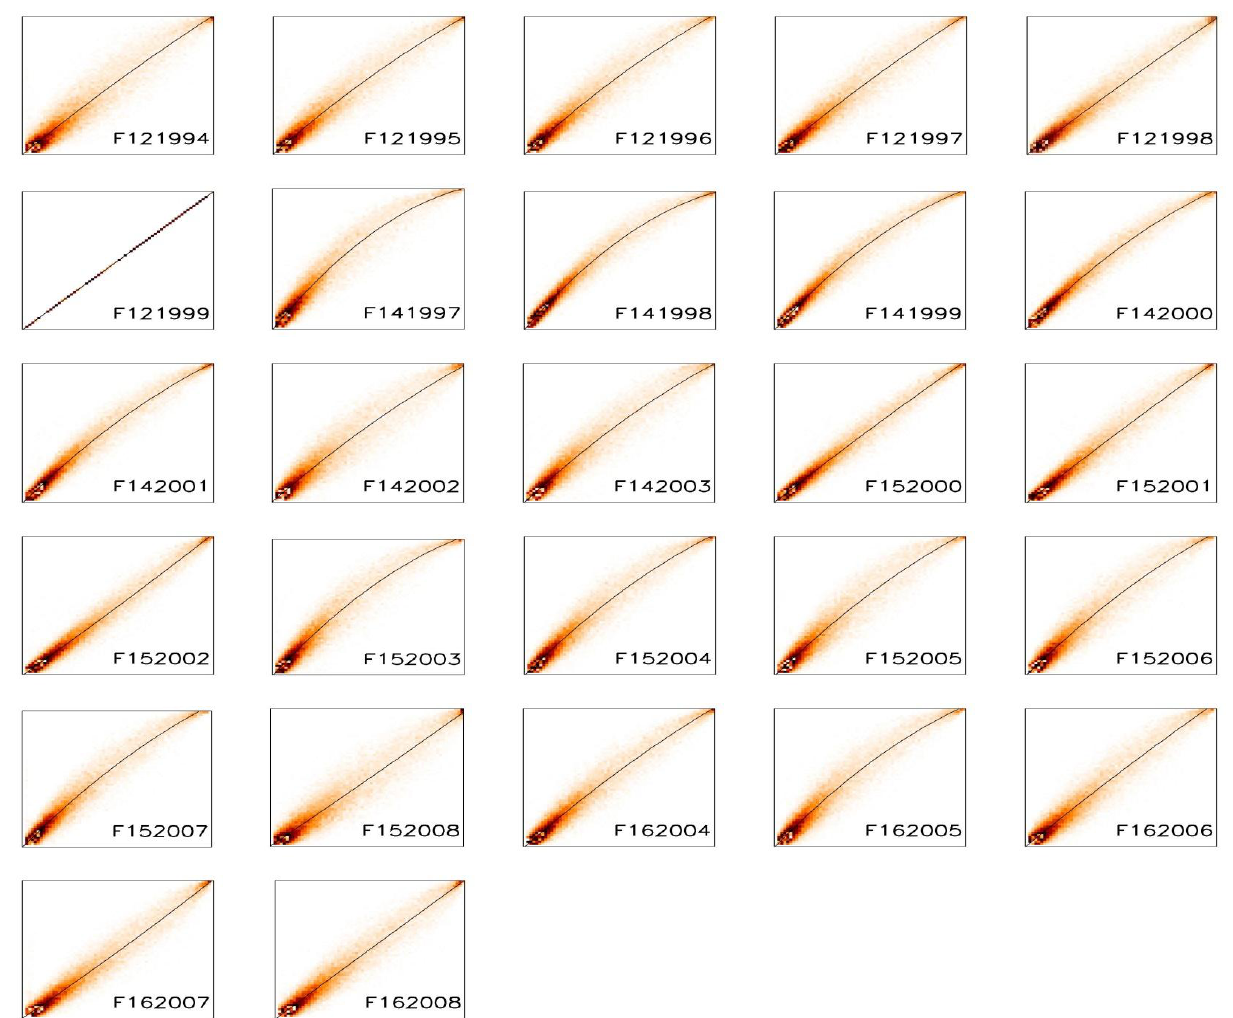
Figure 4. The intercalibration was based on regressions against F121999 images of Sicily (vertical axis). A second order fit is drawn on the density distribution of pixels. Regression results are presented in Table